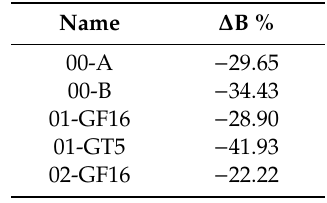
Figure 12. Diagram of % weight loss during the 15 cycles of salts crystallization. Table 10. Average value of percentage weight loss among the sound specimen and the specimen in the end of 15 cycles of salt